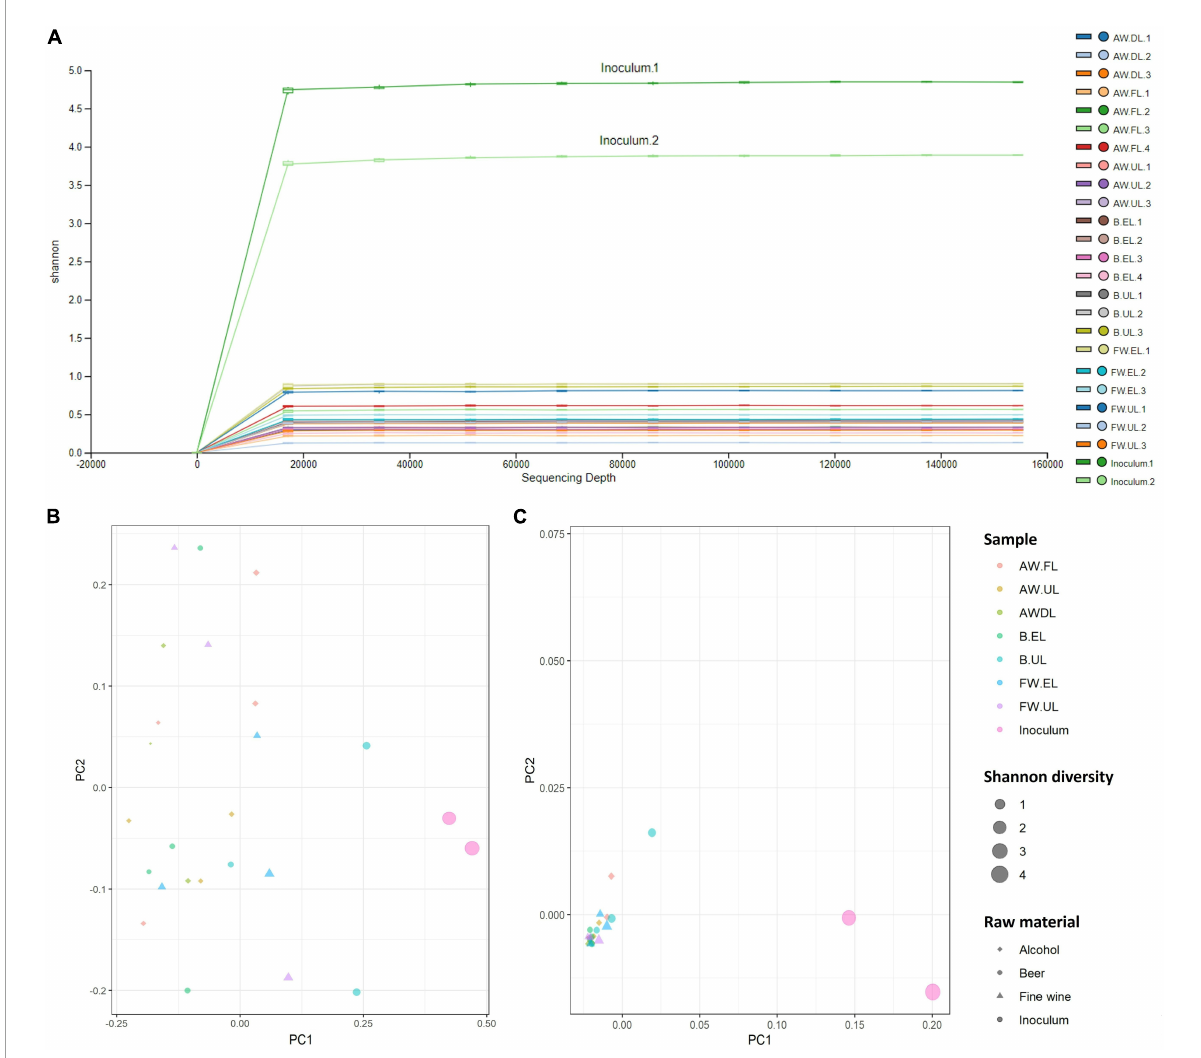
FIGURE5 (A) Alpha rarefaction plot that shows the Shannon rarefaction curve as a biodiversity quantitative index. The box plots represent the distribution of the Shannon metric for each group of samples at each even sampling depth. The lower and upper whiskers of the box are the 9th and 91st percentiles, respectively, while lower and upper extents are the 25th and 75th percentiles; the horizontal bar through the middle is the median value. The line chart connects the medians of the metric distribution across sampling depths. (B,C) Principal Coordinates Analysis (PCoA) by using the unweighted (B) and weighted (C) UniFrac algorithm. Each sample is represented as a dot in a bi-dimensional matrix and the distance between dots indicates the similarity between samples (closer together more similarity). The color, size, and shape of dots represent sampling time, Shannon diversity, and raw material, respectively. AW, alcohol wine; B, beer; FW, fine wine; EL, end of loading phase (FL, fast loading; DL, discontinuous loading); UL, just before